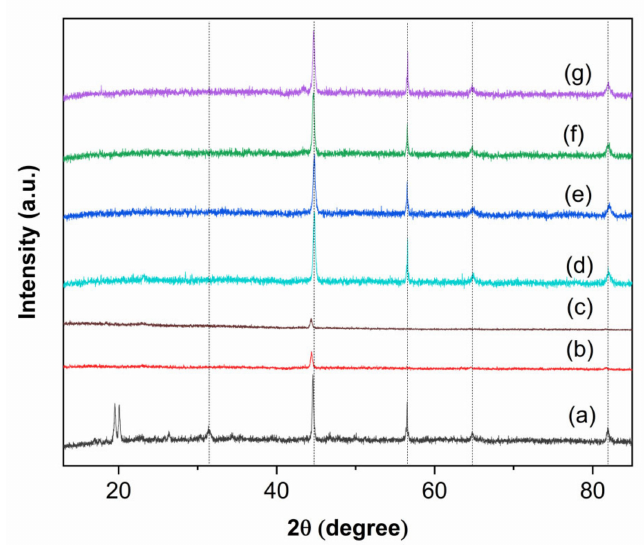
Figure 3. XRD patterns of the ( a ) bare AH36, ( b ) cleaned AH36, ( c ) PANI@AH36, ( d ) Cu@AH36, ( e ) Cu/PANI@AH36-1, ( f ) Cu/PANI@AH36-2, and ( g ) Cu/PANI@AH36-3.